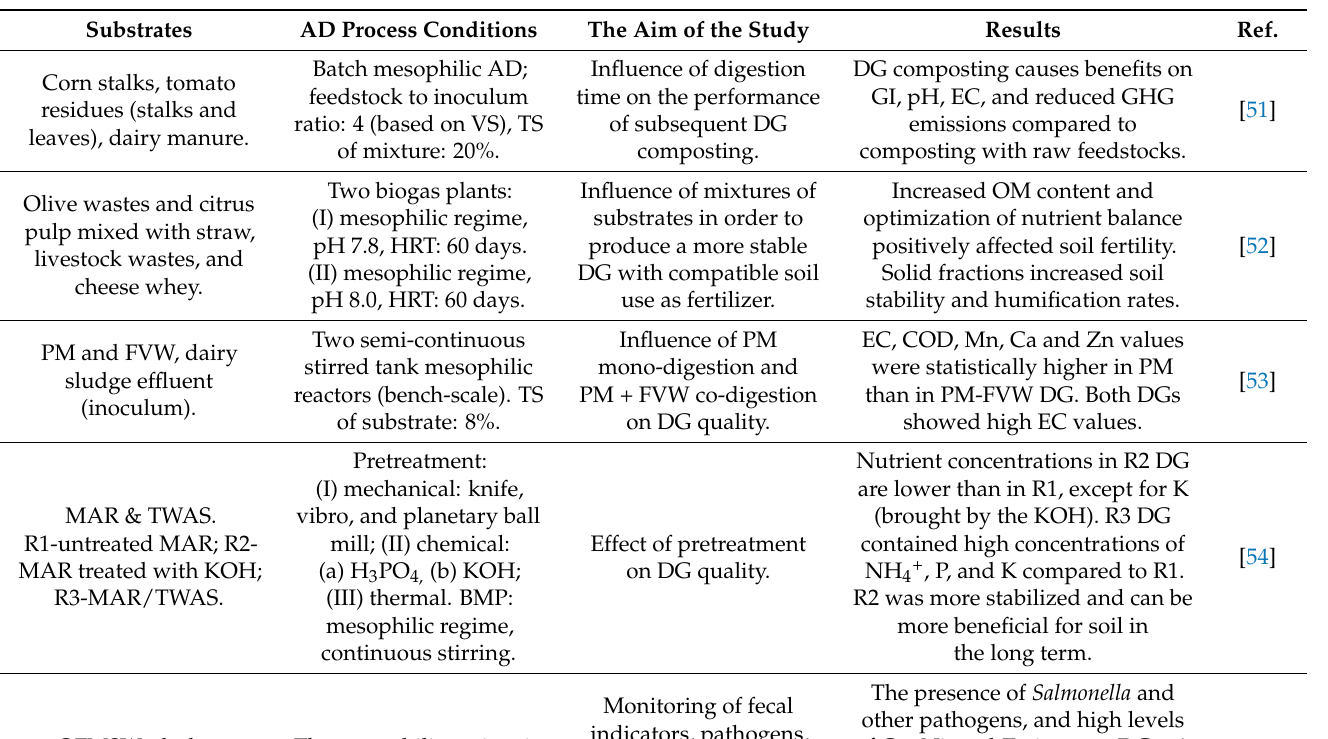
Table 2. AD conducted with the aim to produce quality